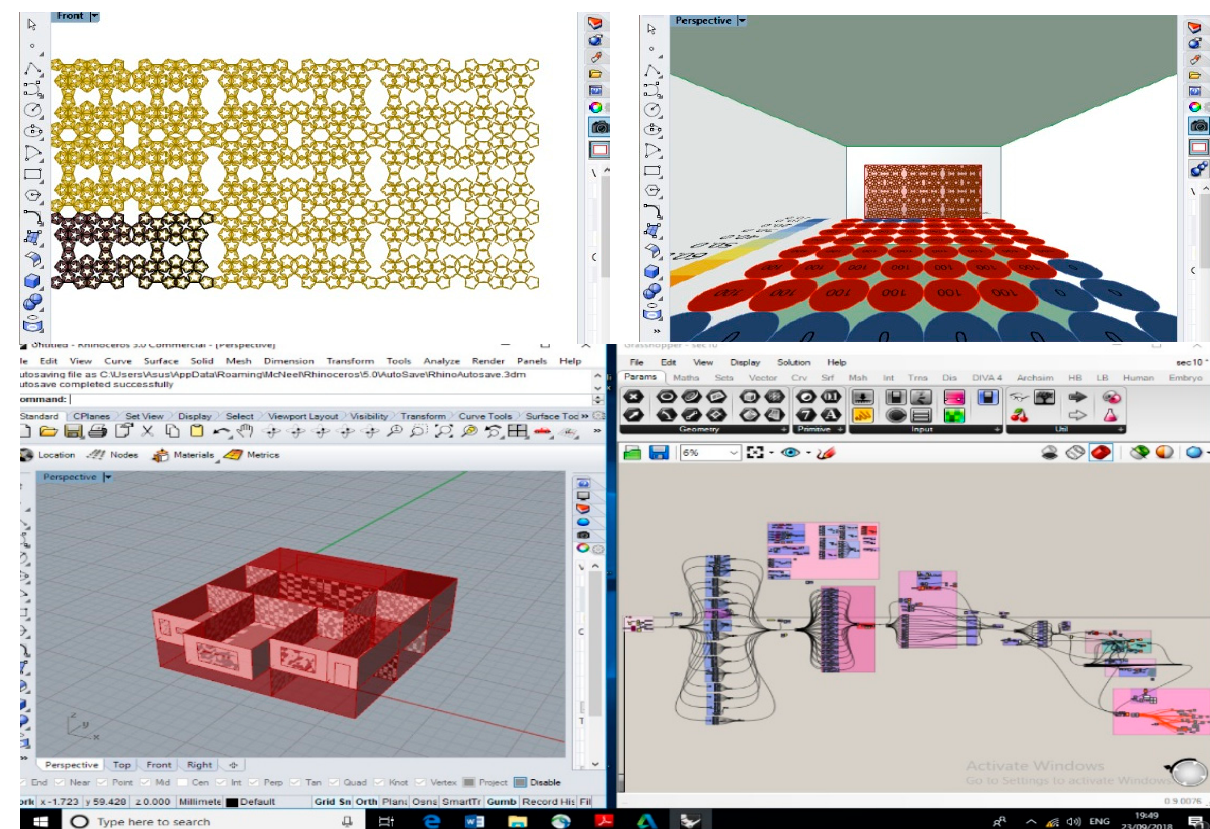
Figure 4. Modelling shading patterns and using them as shading device.